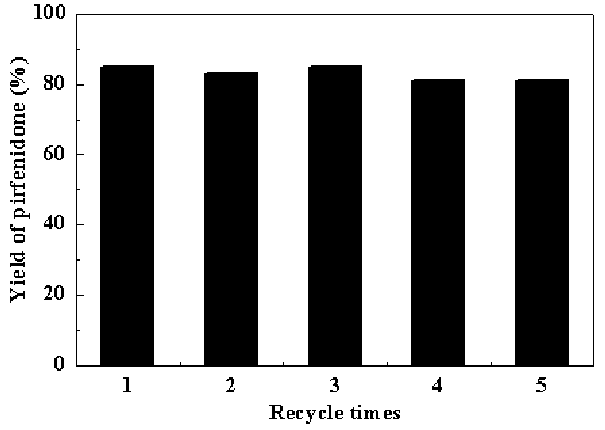
Figure 3. Reuse of Cu-TDPAT in the Goldberg-type C–N coupling reaction of iodobenzene and 5-methyl-2-(1 H )-pyridone. Reaction condition: PhI (1 mmol), pyridone (1 mmol), Cu-TDPAT (0.05 mmol, based on copper), K 2 CO 3 (2 mmol), DMSO (5 mL), 4 h, temperature 120